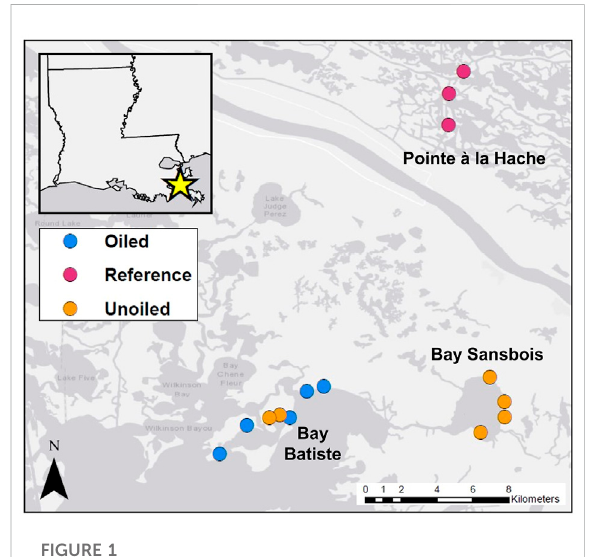
FIGURE 1 Study sites in southeastern Louisiana. Main study sites are located in Bay Batiste and nearby Bay Sansbois. Additional sites were added on the northeastern side of the Mississippi River in 2013, after Hurricane Isaac affected the entire area in